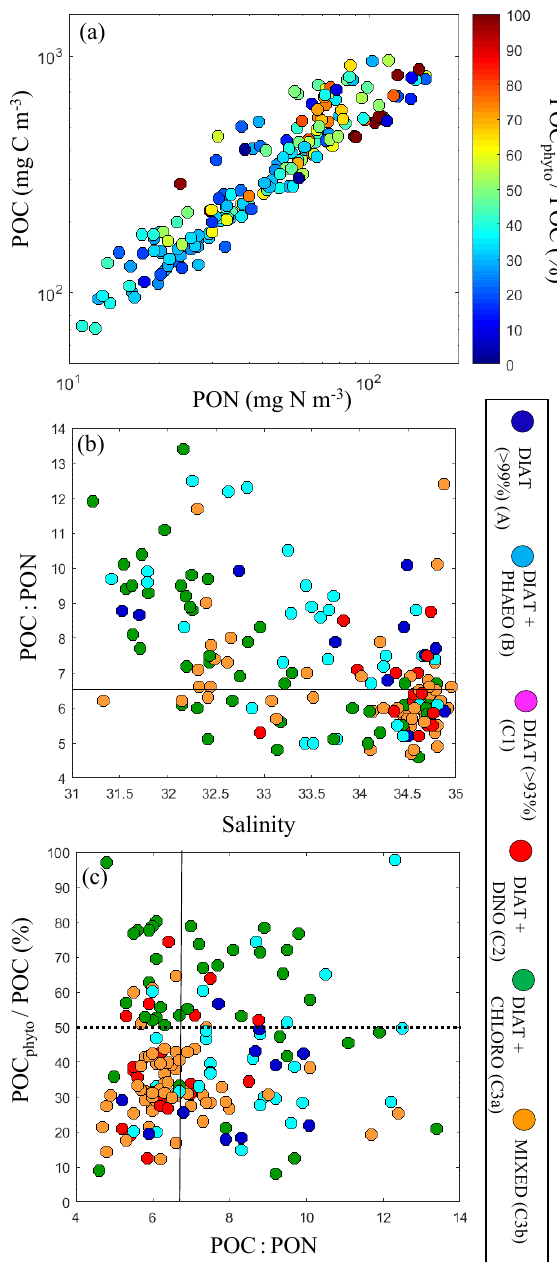
Figure 6. Relationship between particulate organic carbon (POC) and particulate organic nitrogen (PON) in a logarithmic scale, with the points (stations) as a function of phytoplankton-derived or- ganic carbon content (POC phyto / POC, %) (a) , POC:PON ver- sus salinity (b) , phytoplankton-derived organic carbon content (POC phyto / POC, %) versus the POC:PON ratio (c) . The points (stations) in (b) and (c) are colour-coded according to the cluster groups (see details in Fig. 4). Solid lines in (b) and (c) show the C:N Redfield ratio of 6.6 and the dashed line in (c) shows where POC phyto contributes 50% of the total POC.